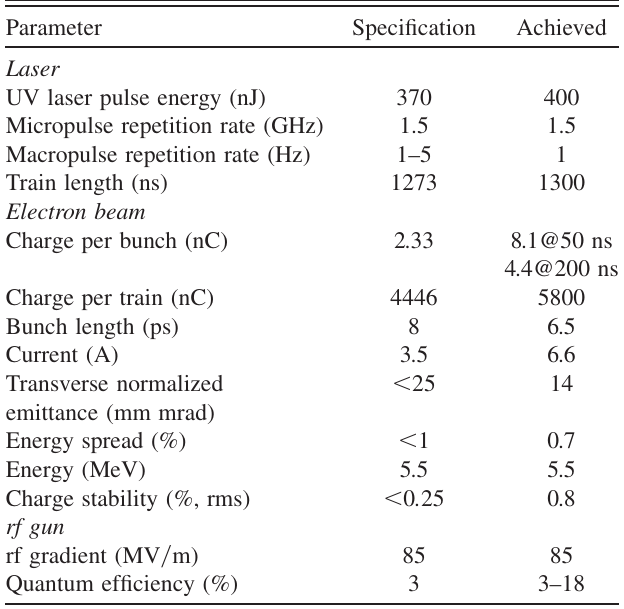
TABLE IV. The specifications for the PHIN photoinjector in comparison with the achieved values during the short intermit- tent runs between